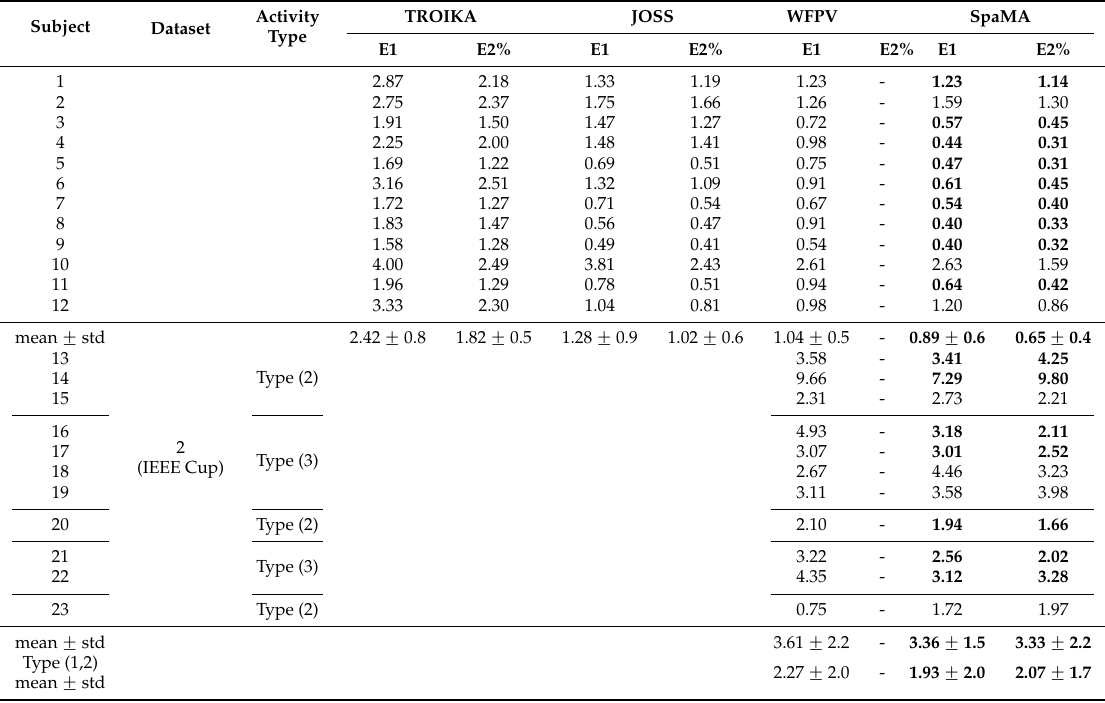
Table 3. SpaMA algorithm performance comparison.